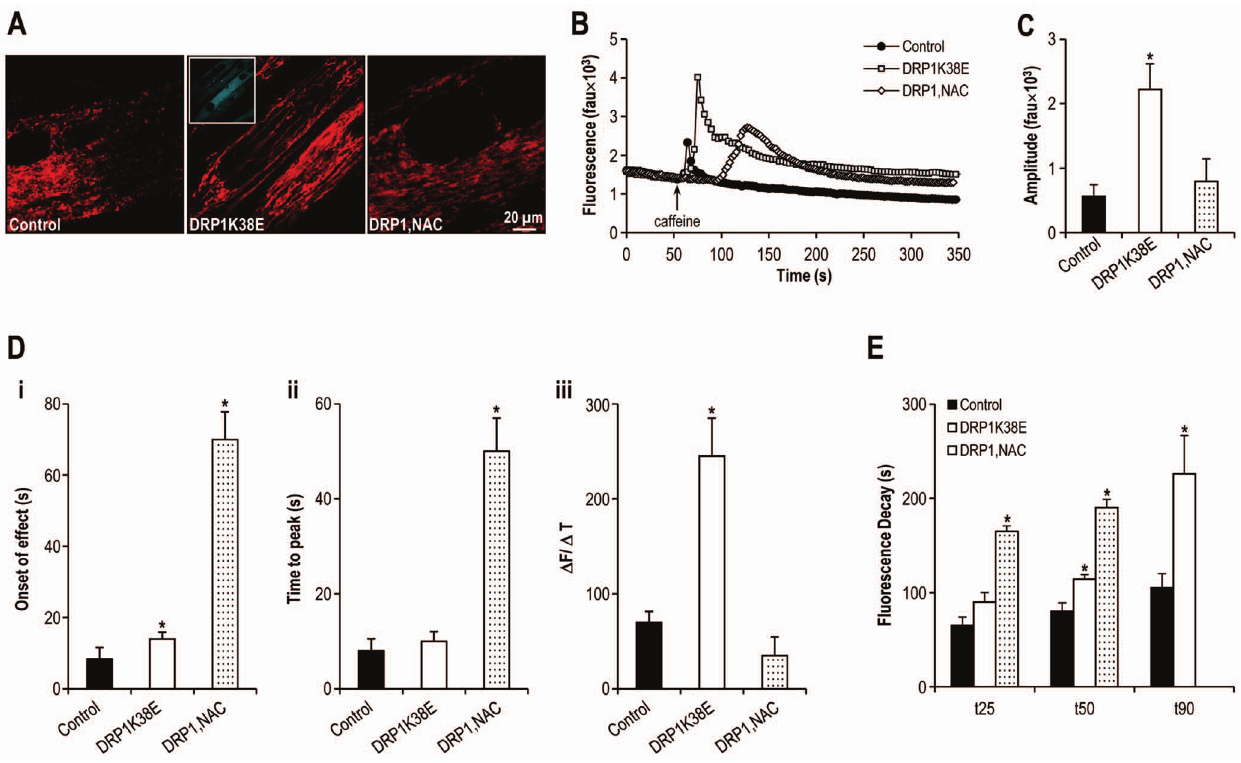
Figure 9. The reducing agent NAC reverses the alterations in SR calcium release induced by ‘forced fusion’. Panel A: Confocal microscopy images of differentiated C2C12 myotubes expressing DRP1K38E or treated with NAC, and loaded with TMRE. Panel B: Representative tracings of the fluorescence profile of myotubes loaded with fluo-4 prior to the application of caffeine to trigger SR calcium release (DRP1K38E, DRP1K38E + NAC v control). Panel C: Objective mean quantitative data for fluorescence resulting from caffeine induced calcium release (DRP1K38E, DRP1K38E + NAC v. control). Panel D: Objective mean quantitative data for fluorescence kinetics profile resulting from caffeine induced calcium release (DRP1K38E, DRP1K38E + NAC v. control). Panel E: Histogram displaying the mean quantitative data relating to the normalization of fluorescence following caffeine application (DRP1K38E, DRP1K38E + NAC v. control). * Denotes p , 0.001 ANOVA, n=40 per group.